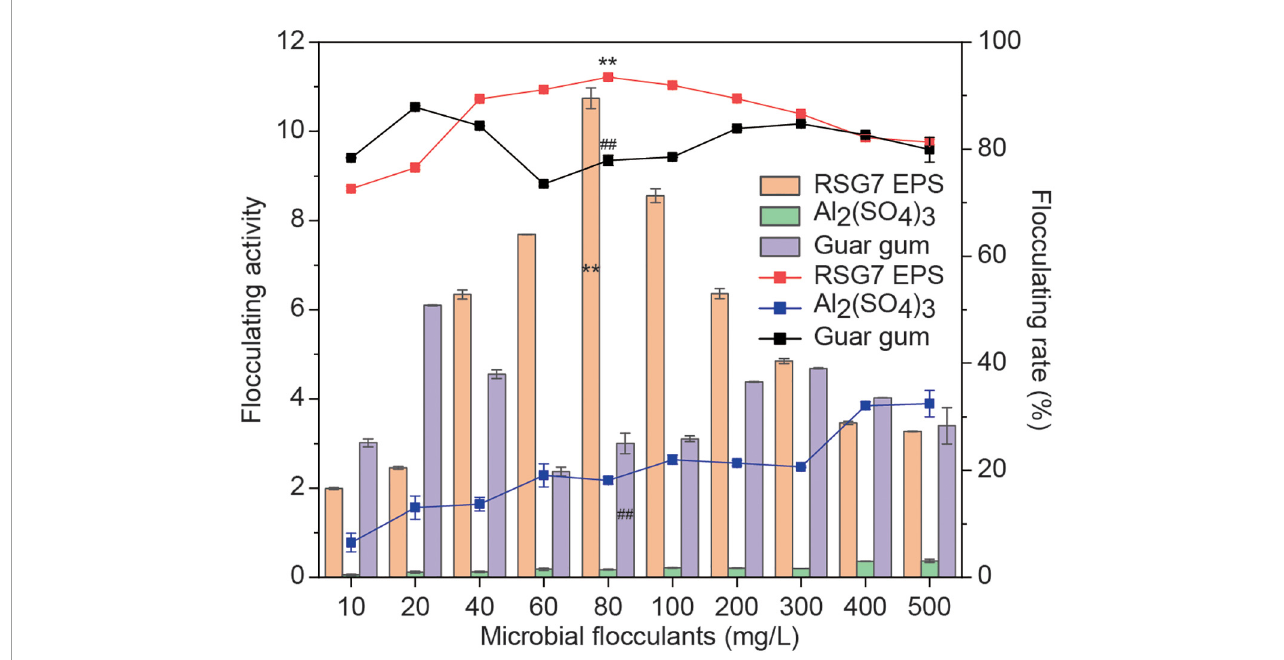
FIGURE10 Flocculation activity and flocculation rate (%) of different microbial flocculants at a concentration range of 10–500 mg/L. Data represent the mean ± SD of three determinations. p < 0.01 is indicated by ** for RSG7 dextran versus Al 2 SO 4 , and p < 0.01 is indicated by ## for Guar gum versus Al 2 SO 4 .